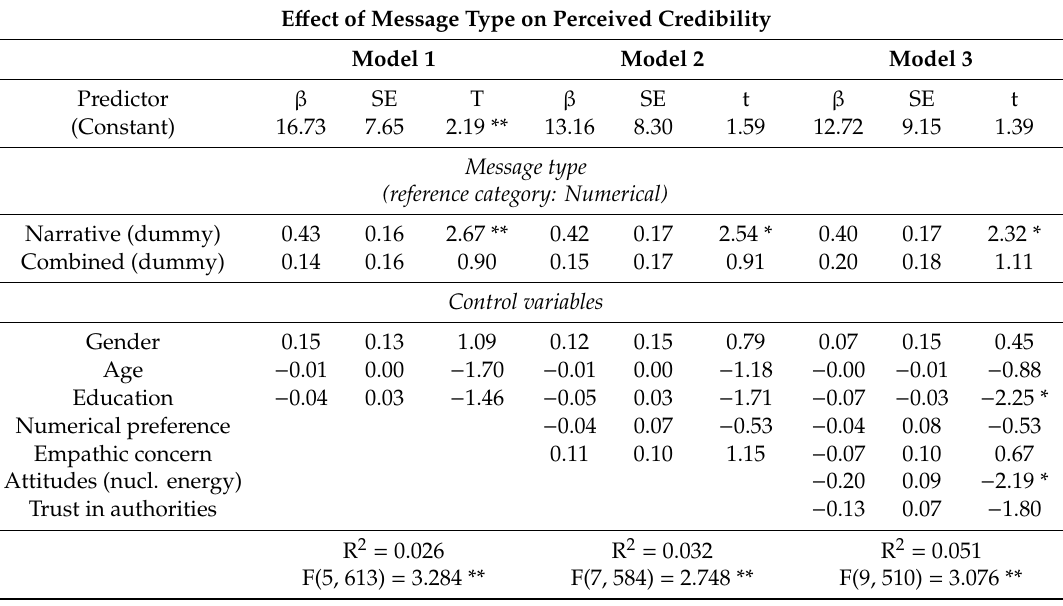
Table 1. E ff ect of message type on perceived message credibility.